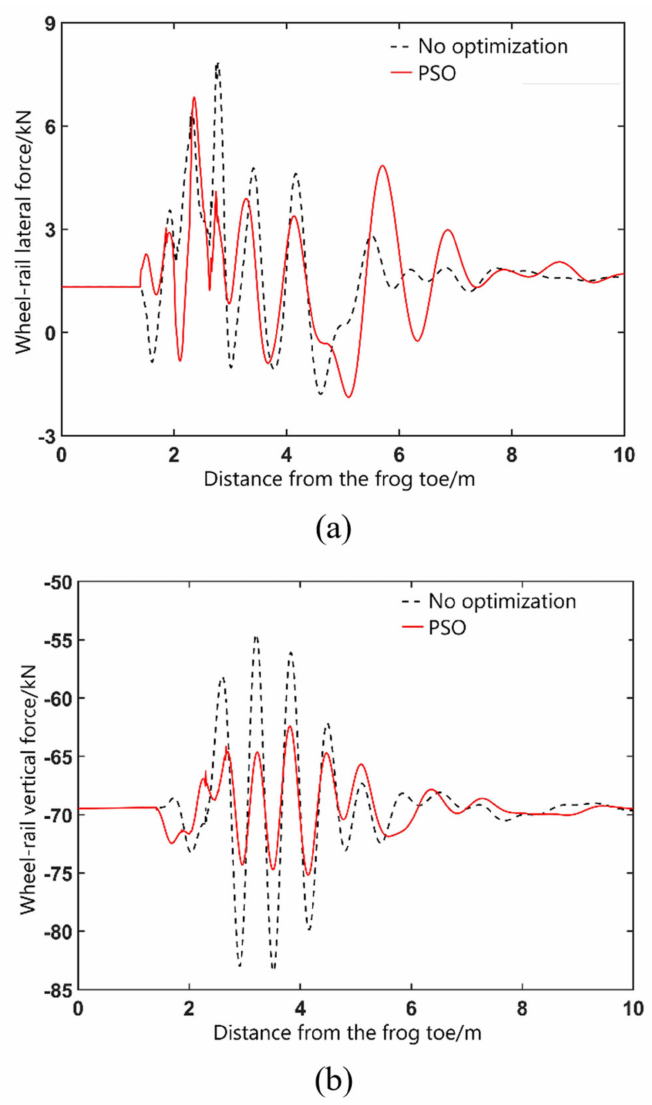
Figure 11. On the stock rail side: ( a ) Wheel/rail lateral force; ( b ) Wheel/rail vertical